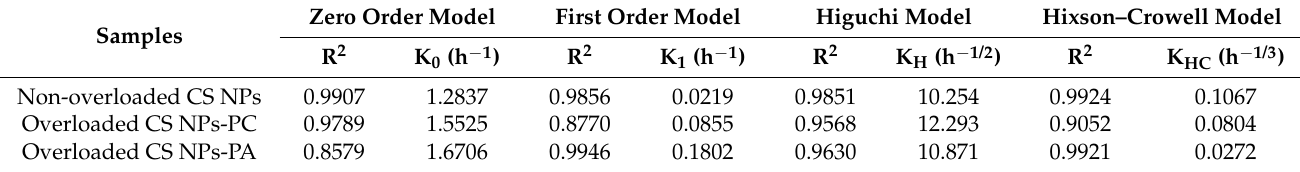
Table 4. Regression coefficient (R 2 ) and rate constant (K i , i = 0, 1, H, HC) of IDE release from